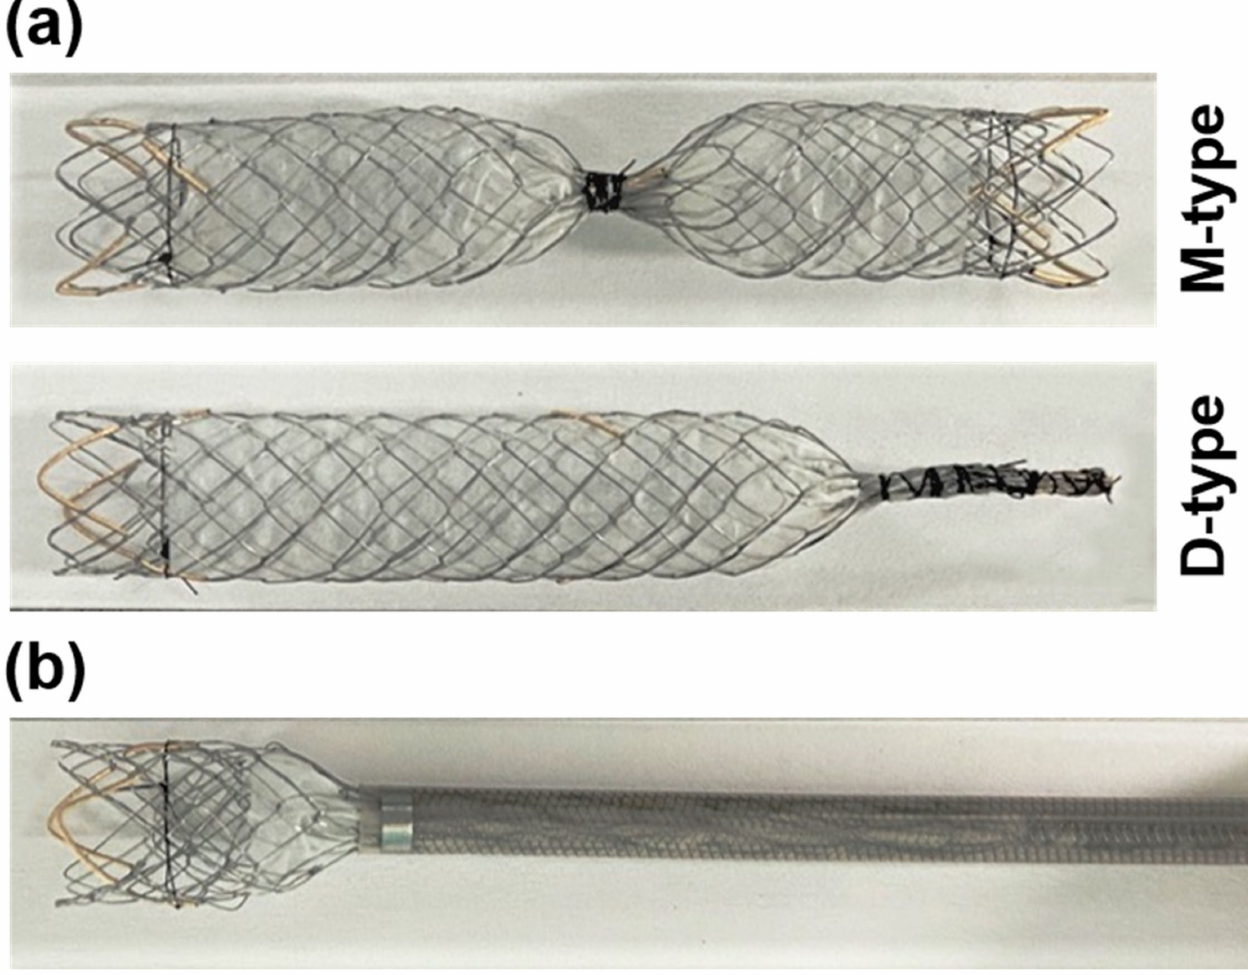
Figure 1. Occlusion stent and delivery system. ( a ) Photographs showing the two types of occlusion self-expandable metallic stents (SEMSs). From top to bottom: M-type and D-type occlusion SEMSs. ( b ) The delivery system showing a partially deployed occlusion